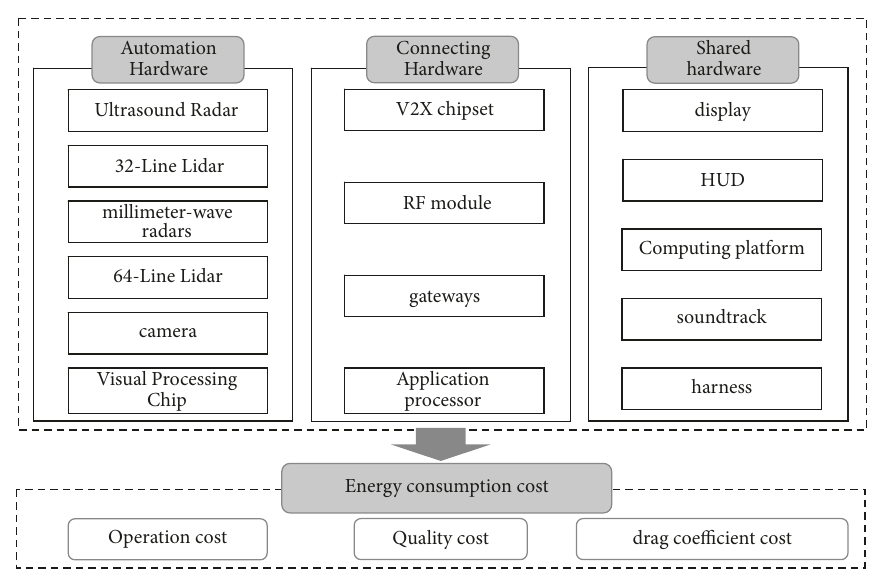
Figure 2: The energy consumption cost evaluation